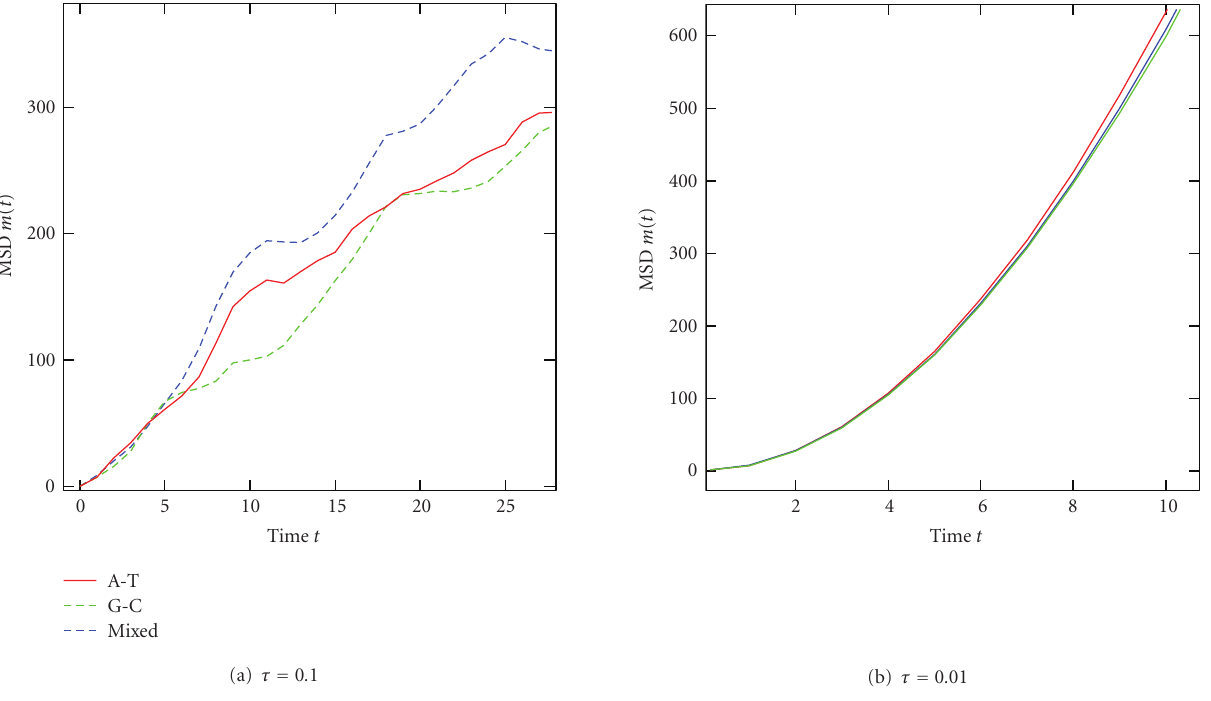
Figure 8: Short-time behavior of m ( t ) of A-T, G-C, and mixed models with r n 0 = 1 . 0 at (a) τ = 1 and (b) τ = 0 .